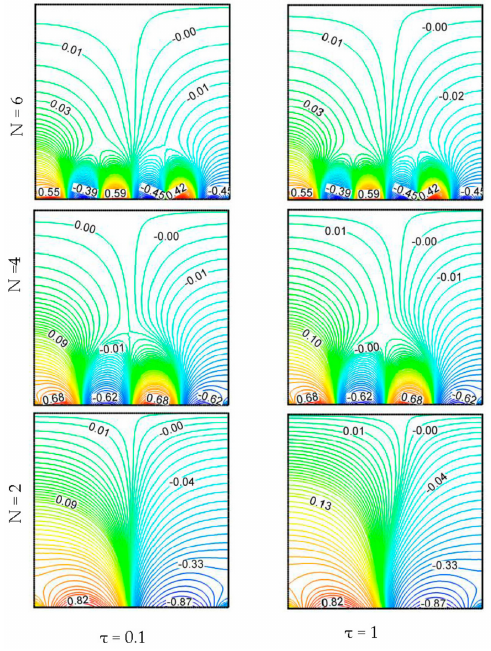
Figure 10. Influence of the even values of N on isotherms for the selected values of τ with Gr = 10 5